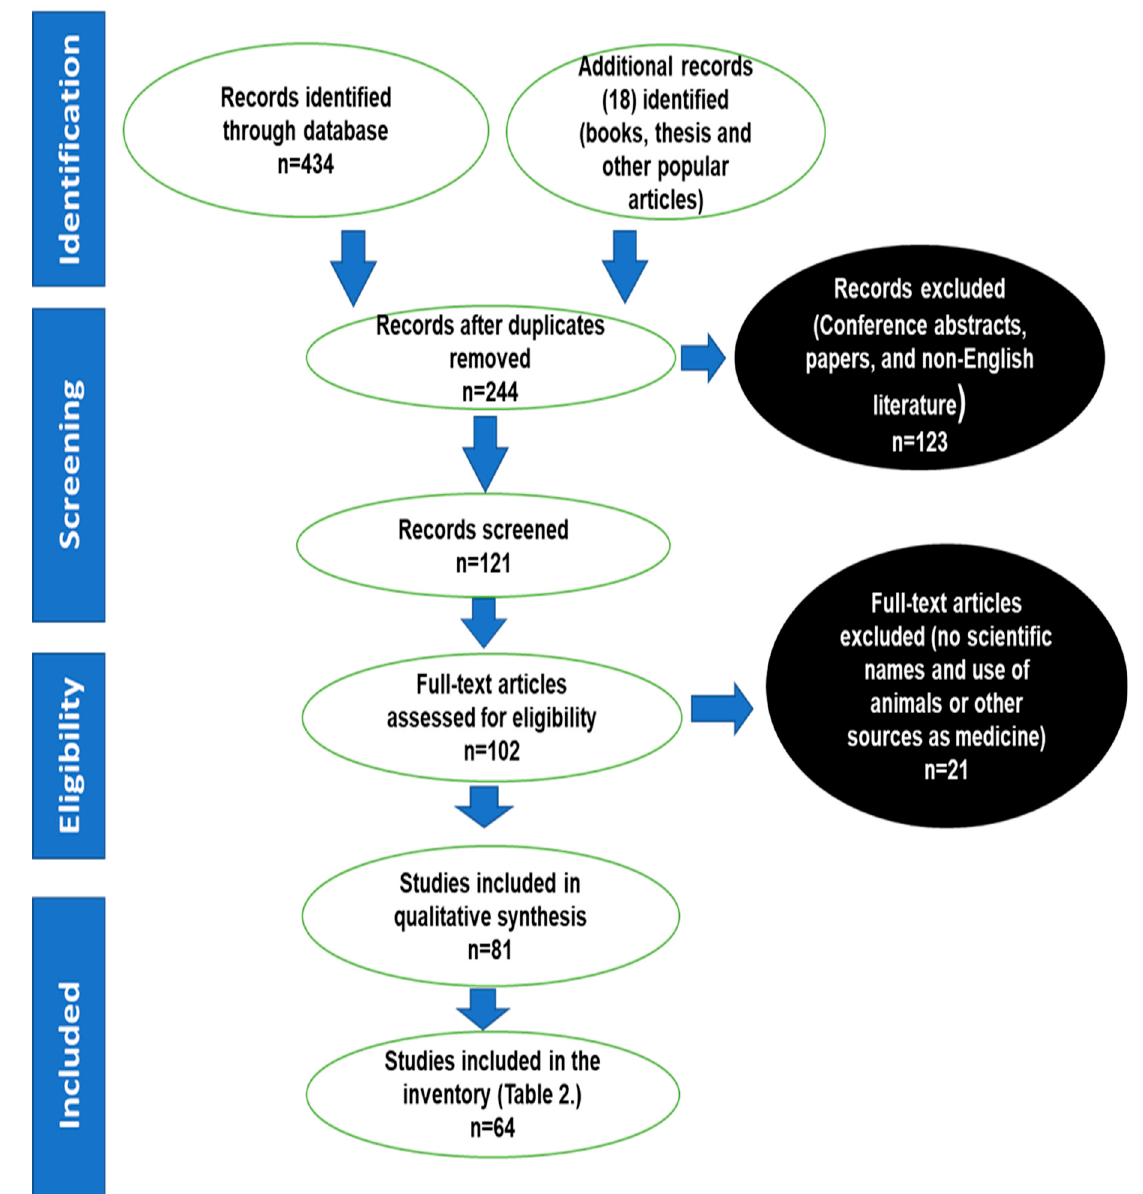
Figure 7. Sources extracted from the literature and used to collate the inventory of medicinal plants used to treat STIs and related opportunistic infections.